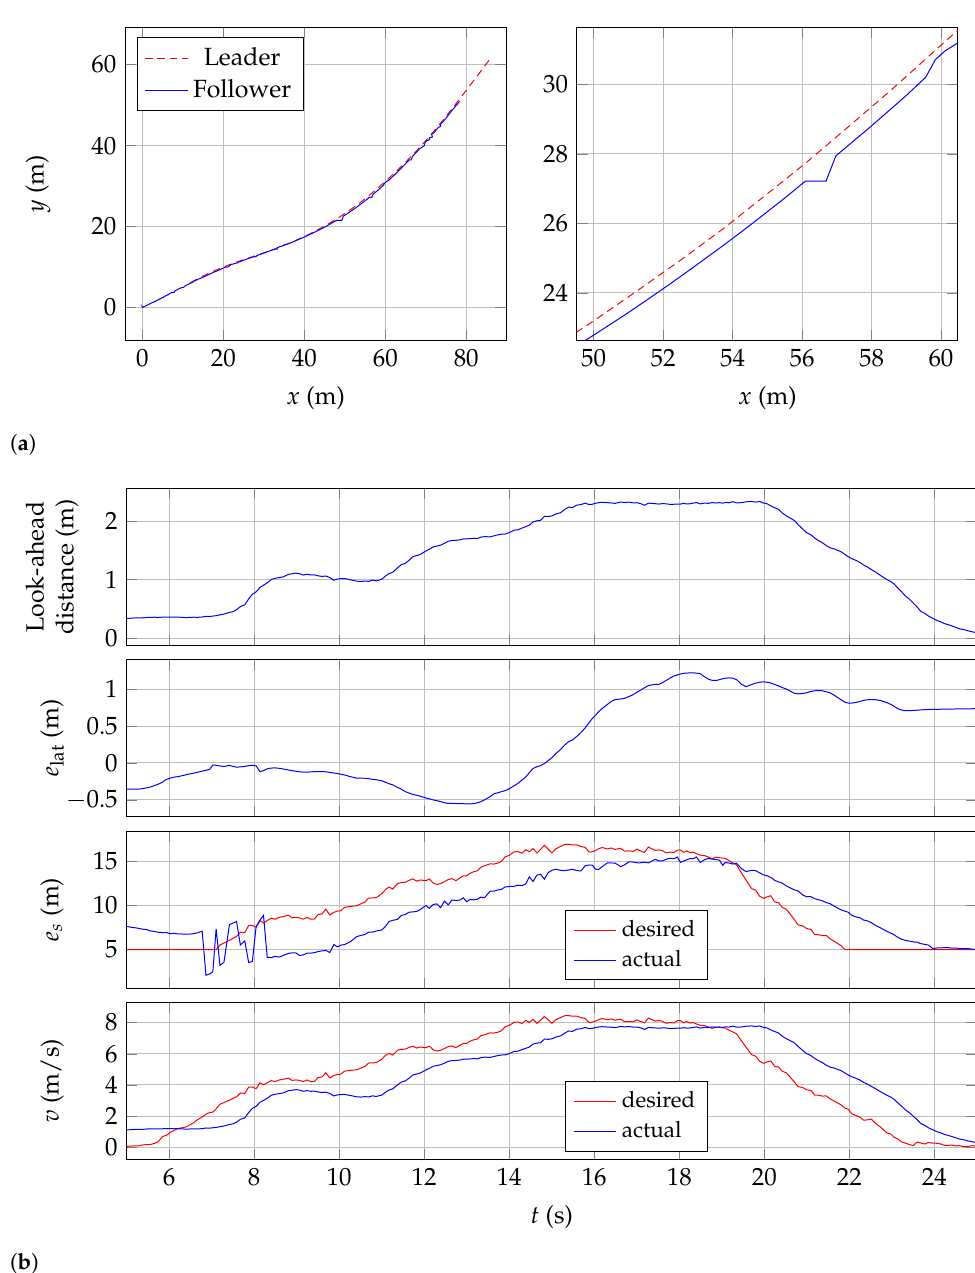
Figure 6. Results from an exemplary field trial run. ( a ) Leader and follower path obtained from differential GPS. The close-up (right figure) also shows an outlier around coordinate (57, 27). Due to its minor character and time constraints, we did not investigate the root cause. ( b ) Speed-dependent look-ahead distance, related lateral-tracking error, and longitudinal control signals in terms of distance and